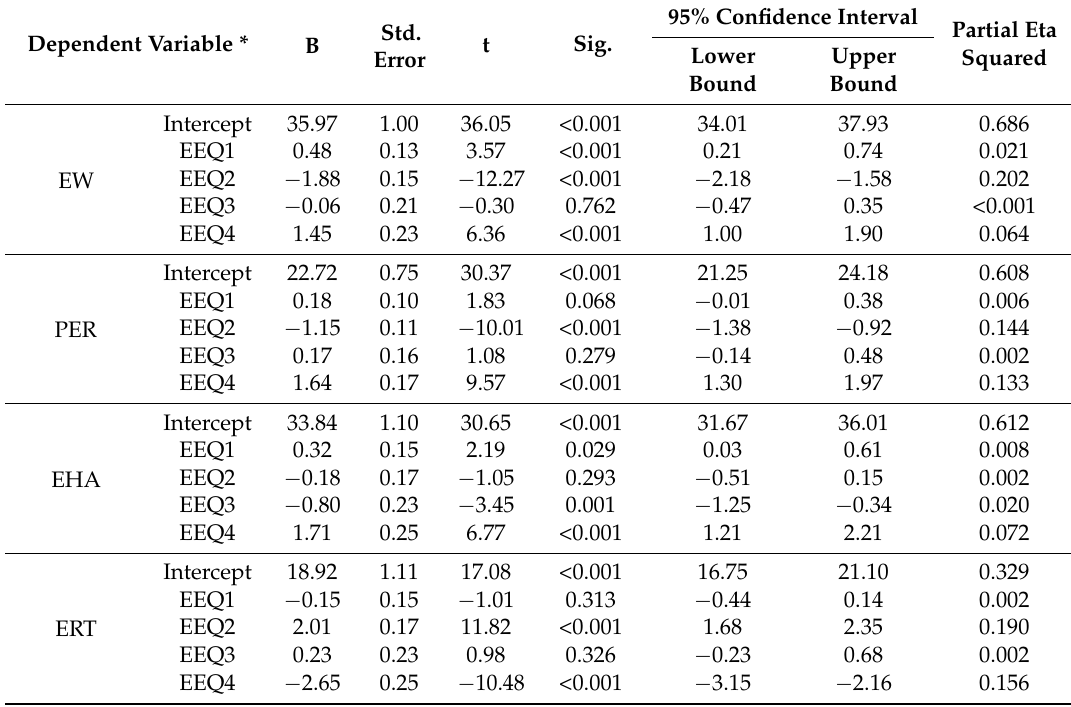
Table 5. Relationships between exposure sources of oil pollution and emotional reactions of the study population. Dependent Variable * B